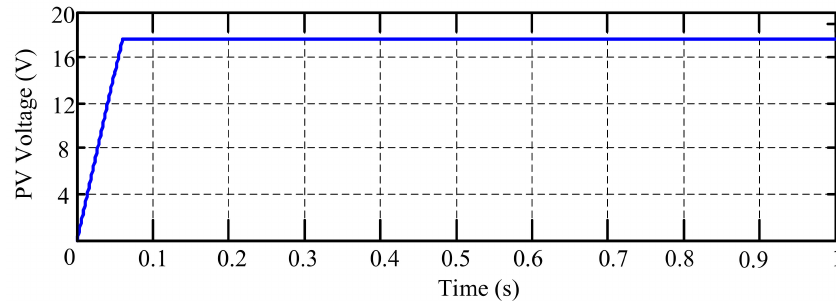
Figure 18. PV voltage simulation of DSM based FLC at normal condition.